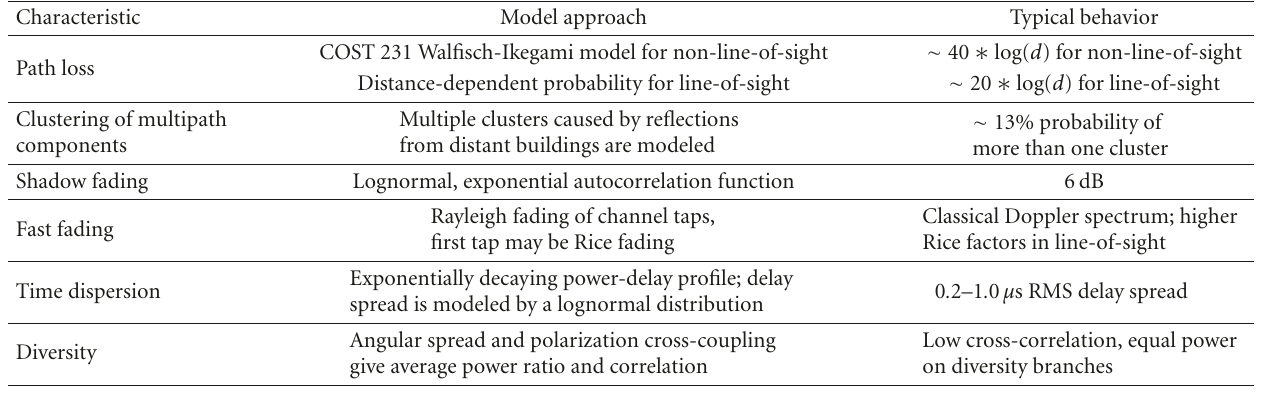
Table 1: Key characteristics of the COST 259 channel model.